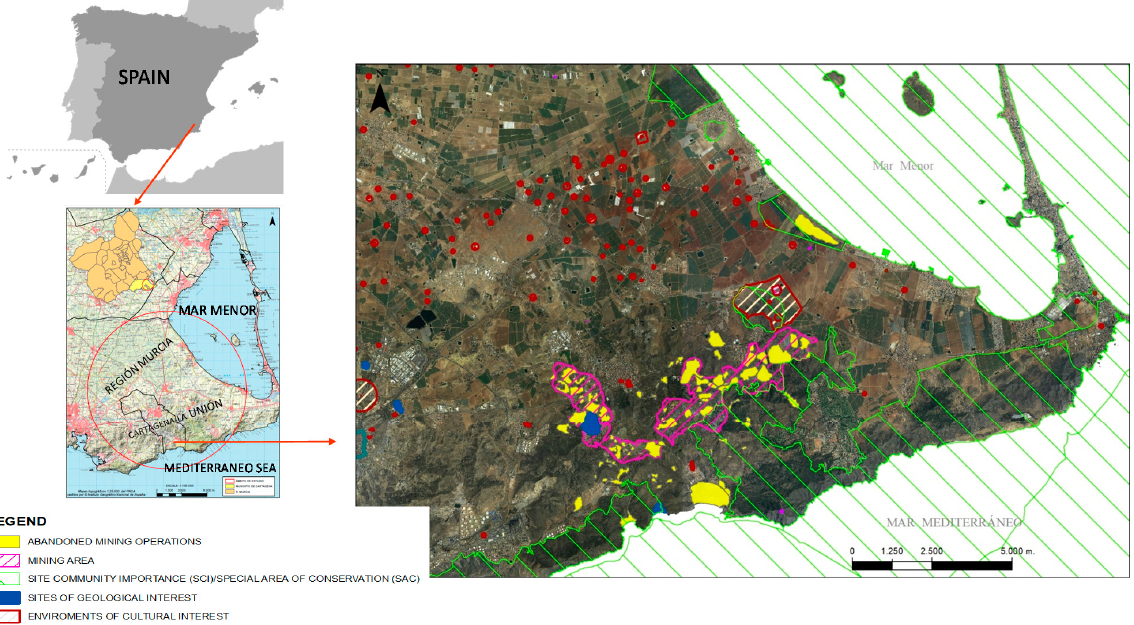
Table 1. Protected areas affected by the mining activities of the study zone .